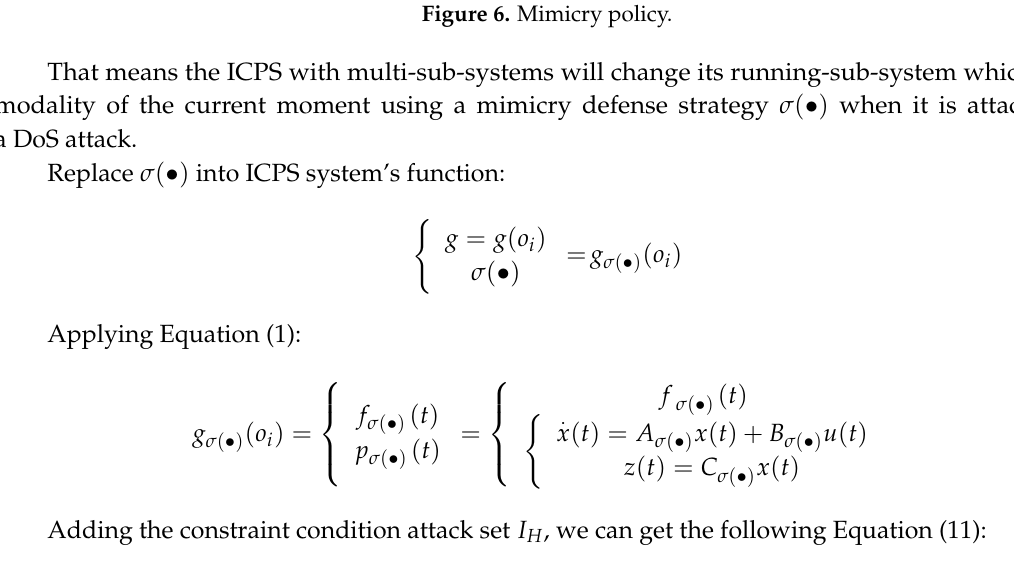
Figure 6. Mimicry policy.